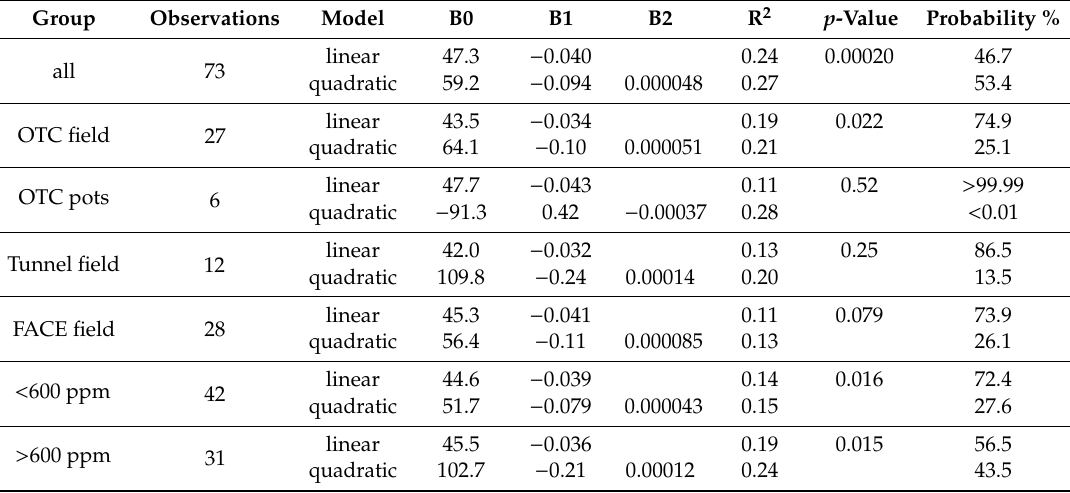
Figure 3. Relationship between the relative CO 2 response for grain yield and absolute grain yield in aCO 2 (control treatment). ( a ) Linear and non-linear regression models for the complete dataset. Subgroups categorized by: ( b ) exposure systems (FACE, OTC, and tunnel) and rooting environment (field or pots), ( c ) concentration level of eCO 2 treatment (above or below 600 ppm), and ( d ) region (Asia, Australia, Europe, and North America). Dotted lines represent the 95% confidence interval for the regression models. Grey markers are outliers excluded from the curve fitting. Equations for all regression models are found in Table 2. Table 2. Response functions for the grain yield CO 2 response with absolute grain yield in aCO 2 (control treatment). 1